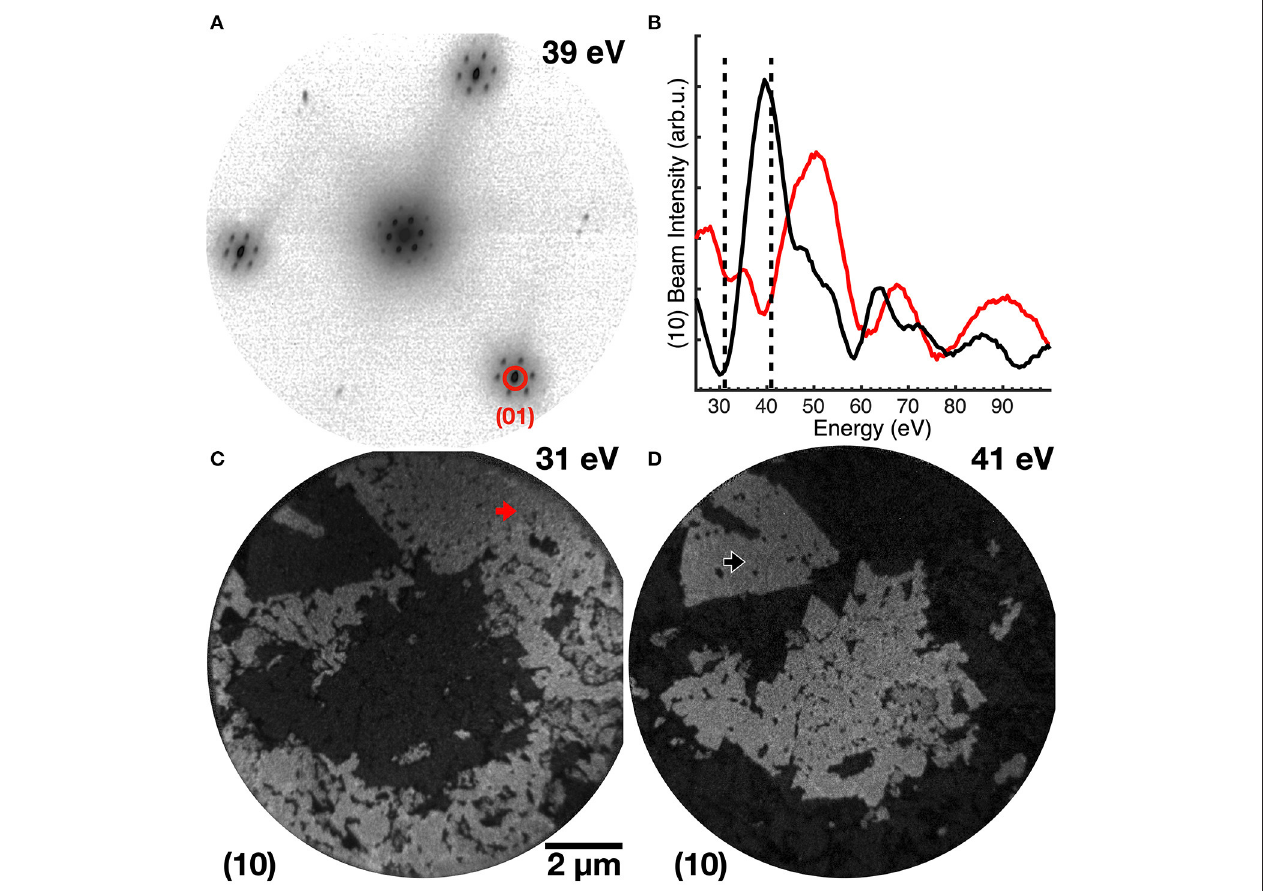
FIGURE 2 | Dark-field low-energy electron microscopy (DF-LEEM) measurement using the (10) beam of the MoS 2 LEED pattern, as seen in (A) at 39eV. The integer beam intensity of each domain is shown in (B) . At the two indicated energies only one of the domains significantly contributes to the beam intensity and thus appears bright: (C) majority domain (red line and arrow) and (D) minority domain (dark line and arrow). No traces of the BL-MoS 2 (cf. Figure 5 ) are visible in the dark appearing